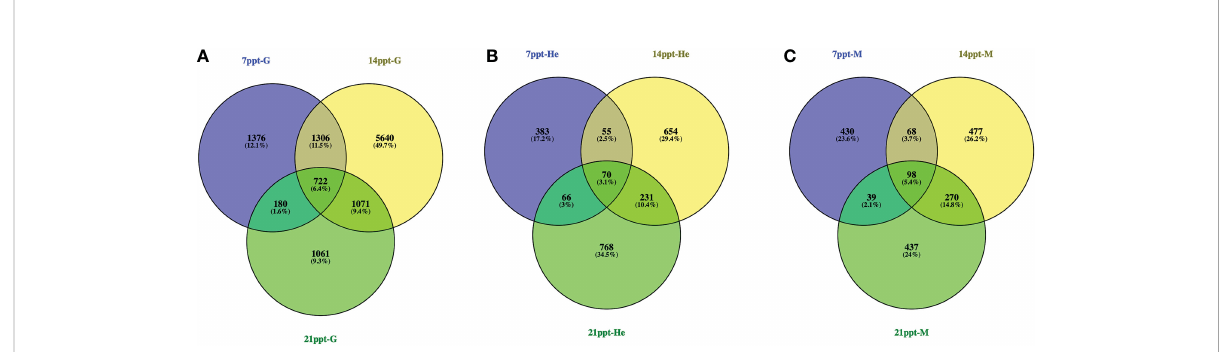
FIGURE 7 Venn diagram of DEGs of Macrobrachium nipponense in 7, 14 and 21ppt salinity treatment comparisons in the gills ( A : 7 ppt-G, 14 ppt-G, 21 ppt-G), hepatopancreas ( B : 7 ppt-He, 14 ppt-He, 21 ppt-He), and muscle ( C : 7 ppt-M, 14 ppt-M, 21